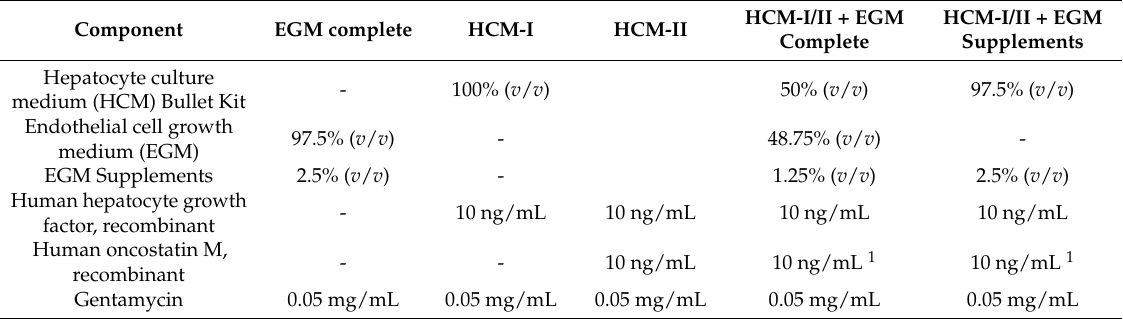
Table 2. Culture media and culture medium combinations used for testing in cultures of human umbilical vein endothelial cells (HUVEC) or human induced pluripotent stem cells (hiPSC).